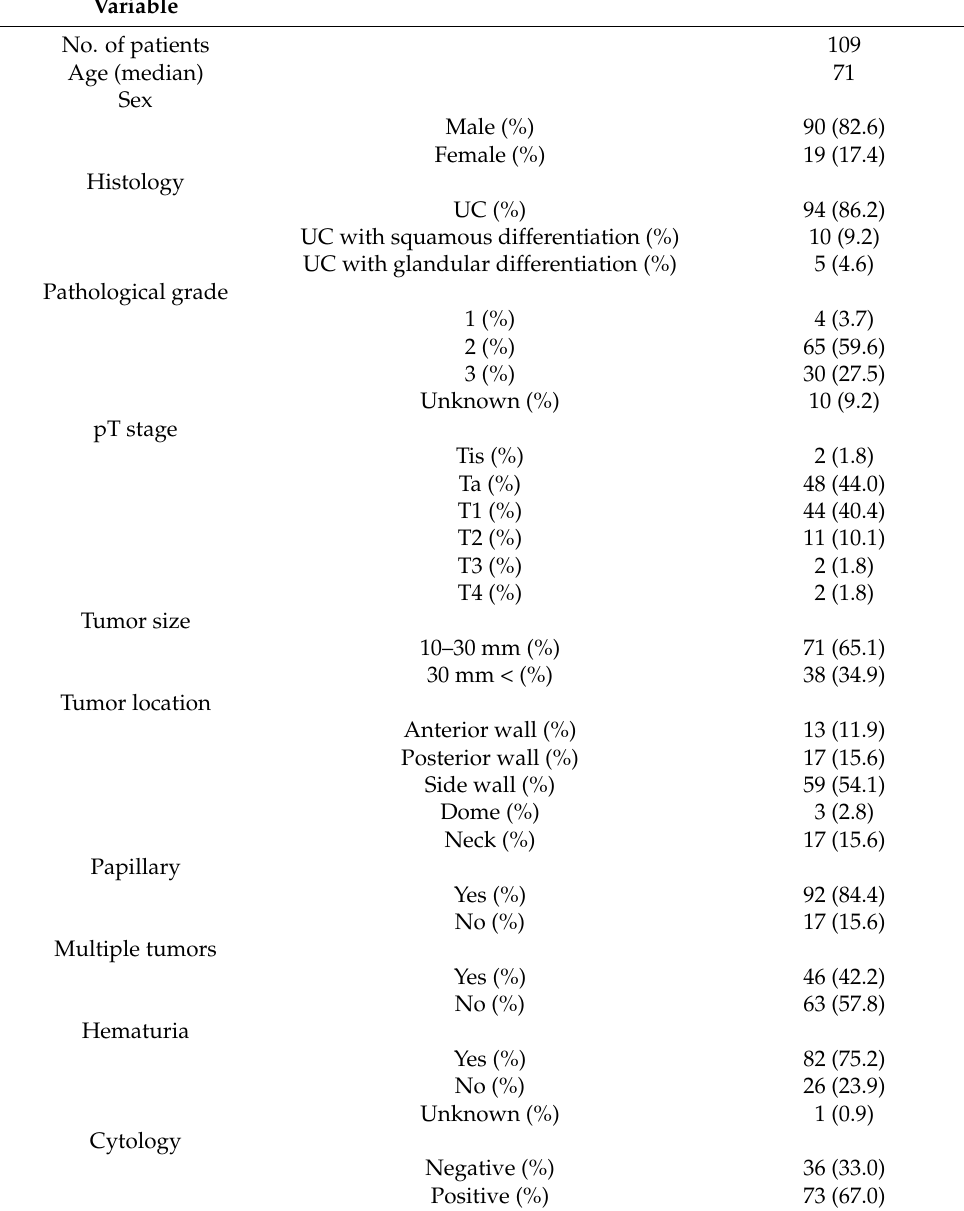
Table 1. Characteristics of the patients with inchworm